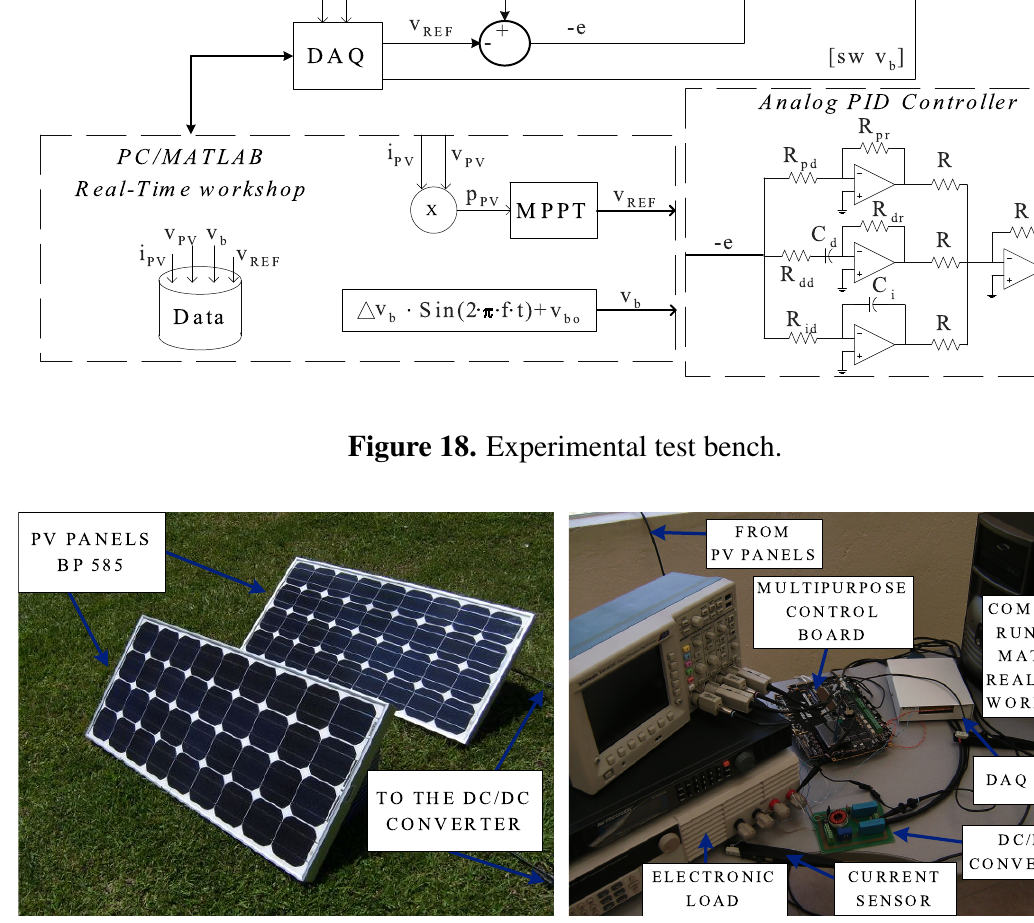
(a) BP585 PV panels (b) Laboratory